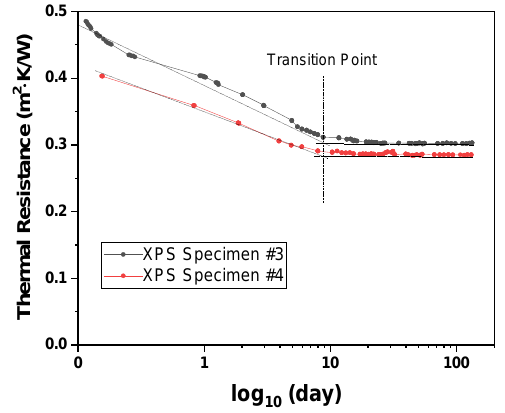
Figure 5. Acceleration test result.